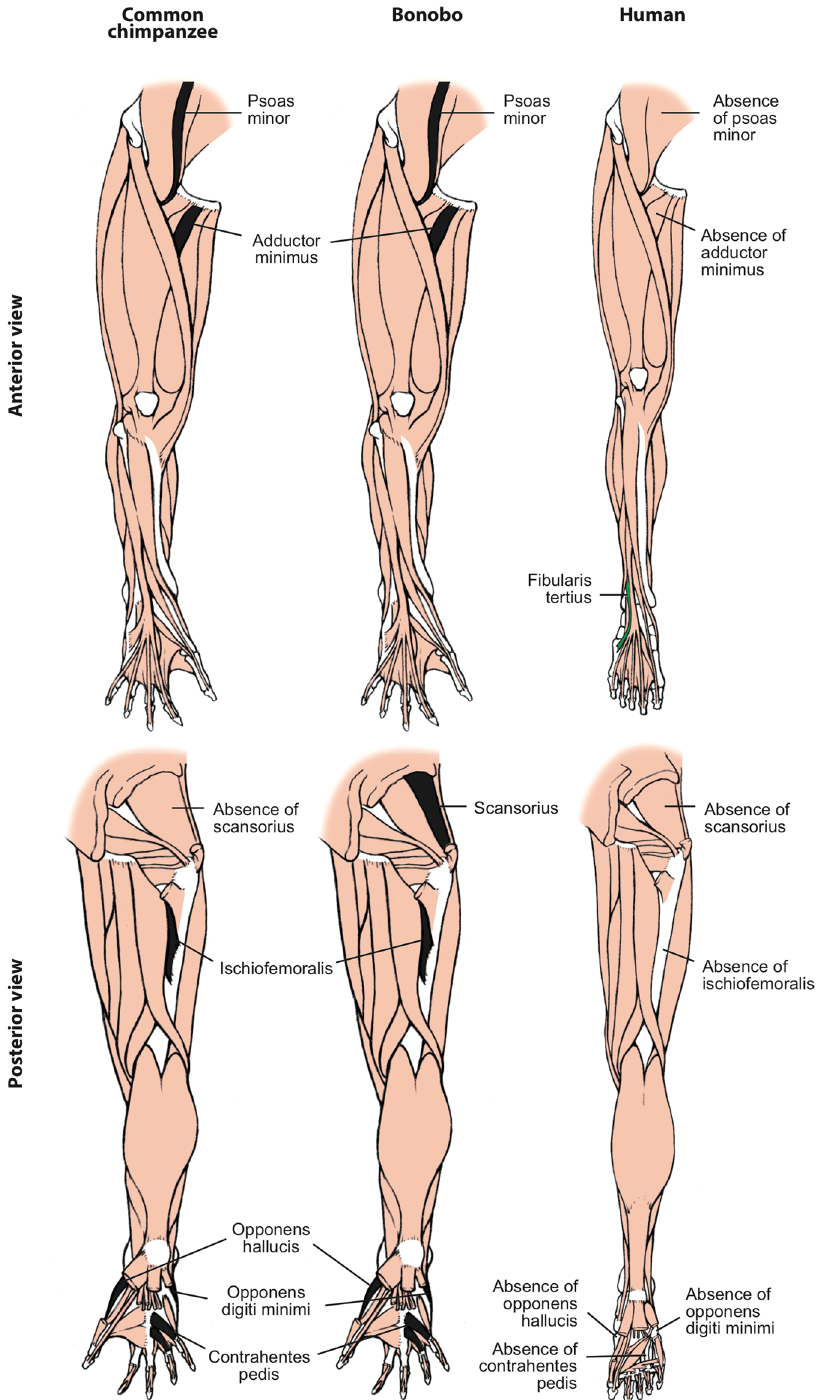
Figure 3. Differences between hindlimb muscles of common chimpanzees, bonobos and modern humans. The only consistent difference between bonobos (center) and common chimpanzees (left) concerning the presence/absence of muscles (shown in colors in the common chimpanzee scheme) is that the latter usually lack the scansorius, as is the case in humans. In contrast, there are many differences between bonobos and modern humans (right) concerning the presence/absence of muscles (shown in colors and/or with labels in the human scheme; muscles present in chimpanzees and not in humans are shown in black, in chimps). See text for more